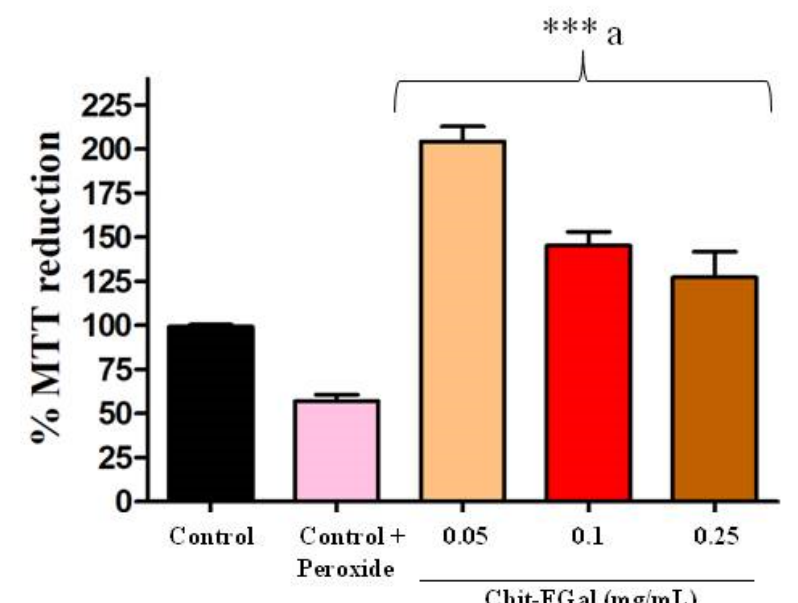
Figure 9. MTT reducing activity of the 3T3 fibroblast cells incubated with Chit-FGal and hydrogen peroxide (H 2 O 2 ) for 6 h. Values are expressed as the mean ± standard deviation at concentrations of 0.05, 0.1, and 0.25 mg/mL. *** indicates the significant difference between the control and samples ( p < 0.05). a indicates significant difference between the control + peroxide and the tested samples ( p < 0.05).